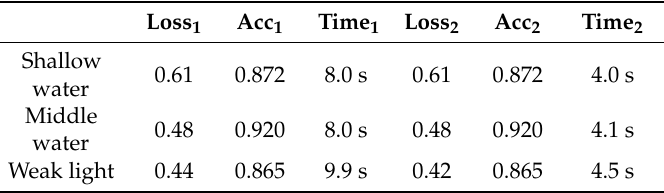
Table 3. Comparison of two strategies.